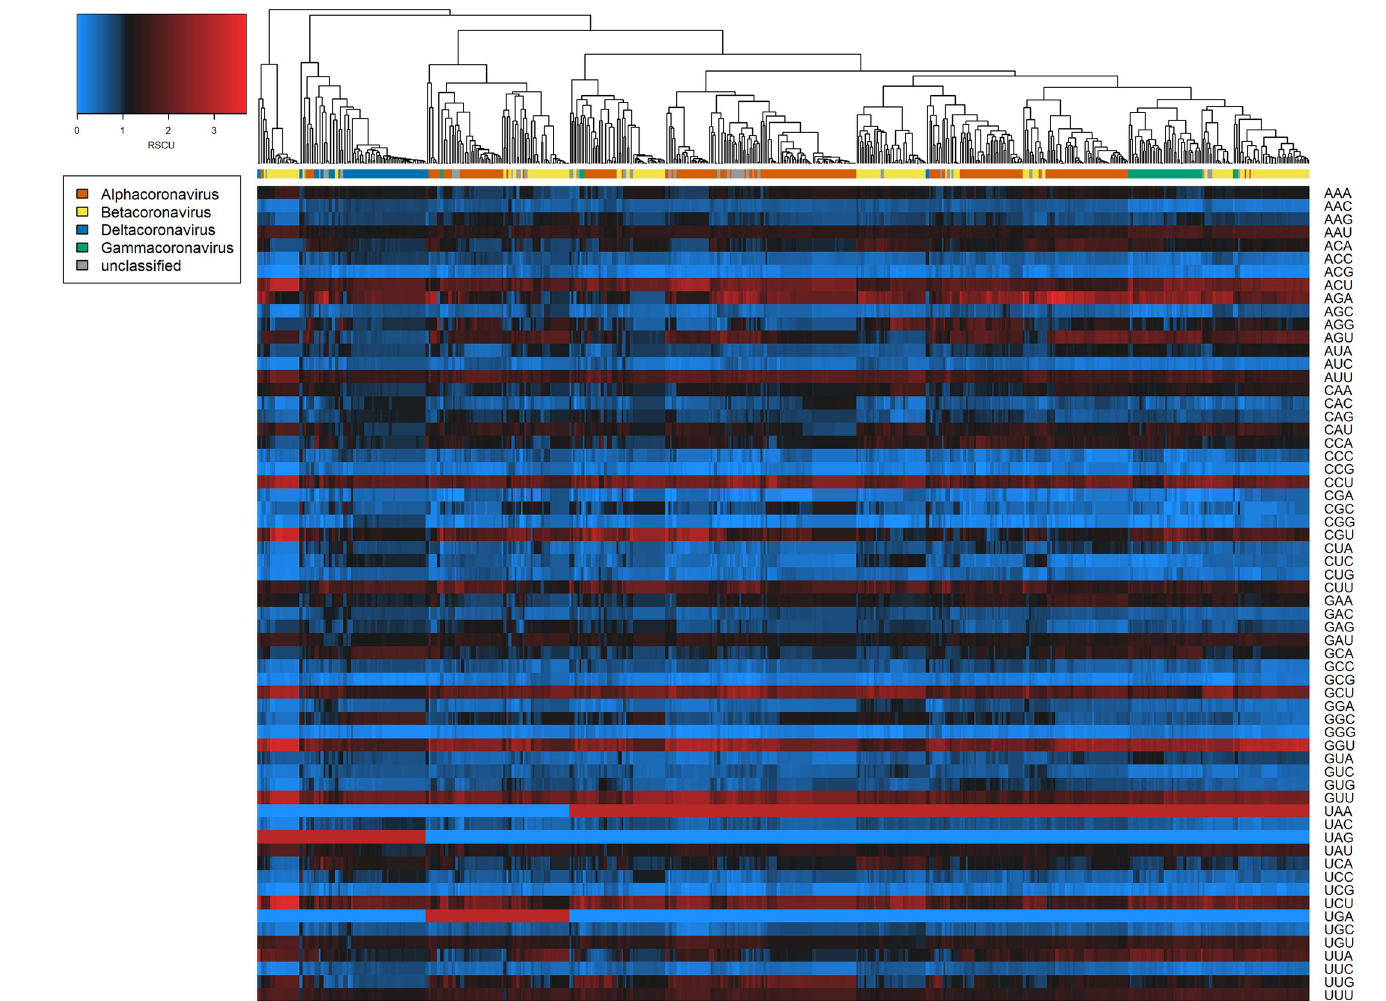
Fig 1. Codon biases (RSCU) across coronavirus spike protein sequences examined. Heatmaps of coronavirus codon usage bias (RSCU) associated with each codon in each spike protein sequence (n = 650). Main colour scale denotes RSCU value, a null value of 1 (black) indicating no difference in codon usage from expectation, with blue and red representing under- or overrepresentation respectively. Dendrogram colour bar denotes taxonomic